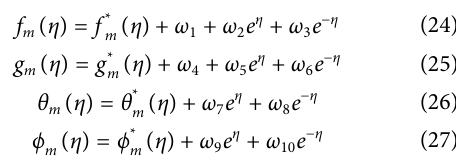
Frontiers in Physics |